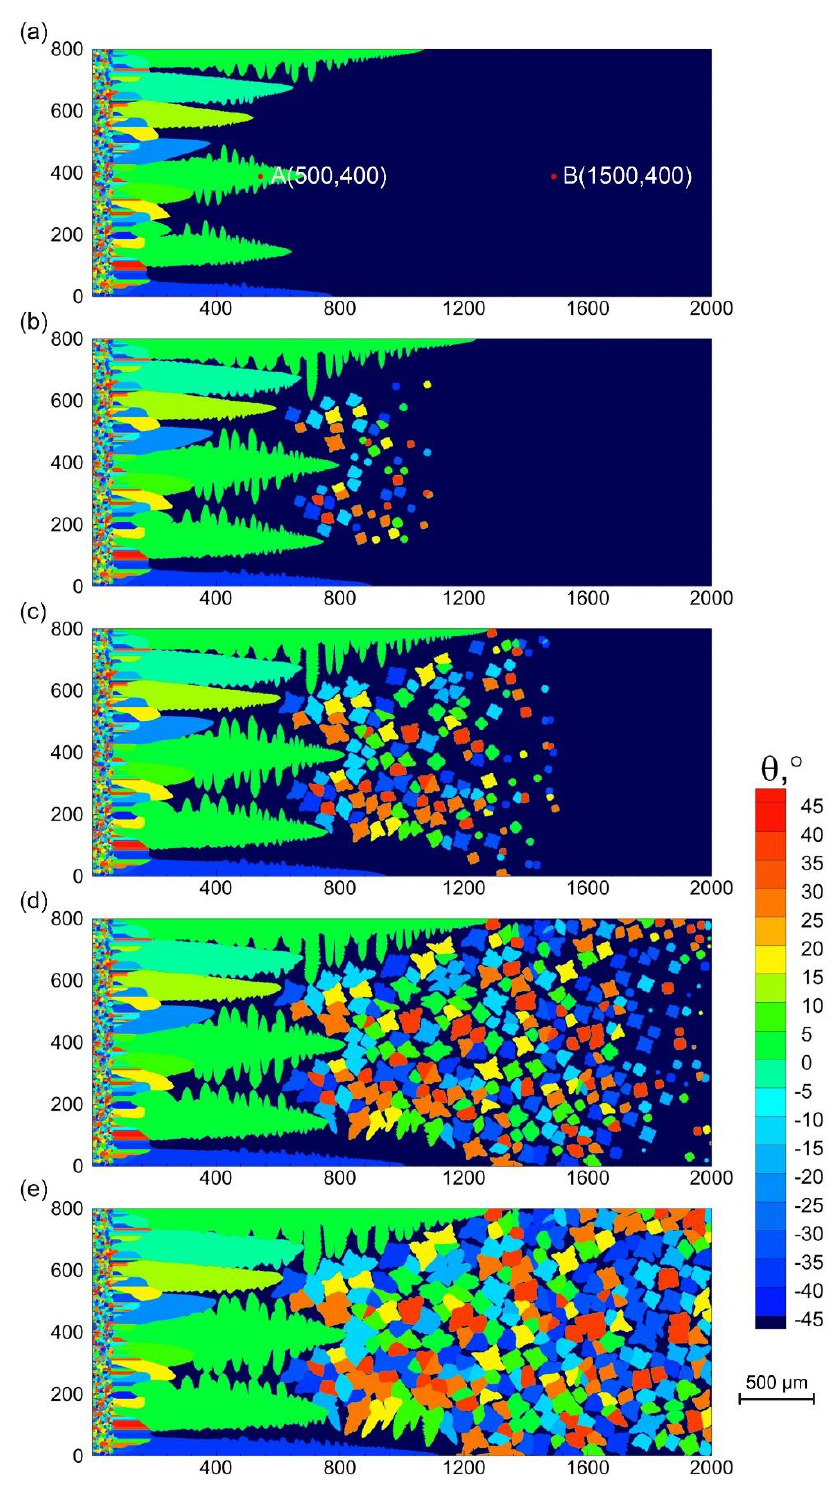
Figure 4. Simulated the process of dendritic structures formed in the melt; different colors repre-sent grains with different crystallographic orientations. The calculation time is 5.5 s, 6.3 s, 7.2 s, 8.5 s, and 11.0 s, from ( a – e ), respectively. The coordinate axis in the figure represents the number of grids, and same meaning is expressed in the following pictures.